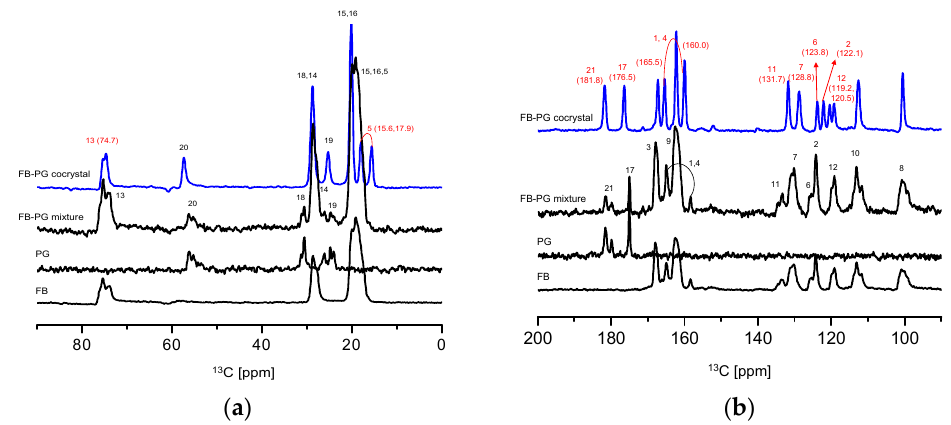
Figure 5. FB-PG (2:1) cocrystal, FB, PG, and FB/PG (2:1) mixture’s solid-state CP/MAS 13 C-NMR spectra ( a ) 90 ppm–200 ppm, ( b ) 0 ppm–90 ppm (Numbers on the peaks are related to numbers in Figure 1 structure and peak location).